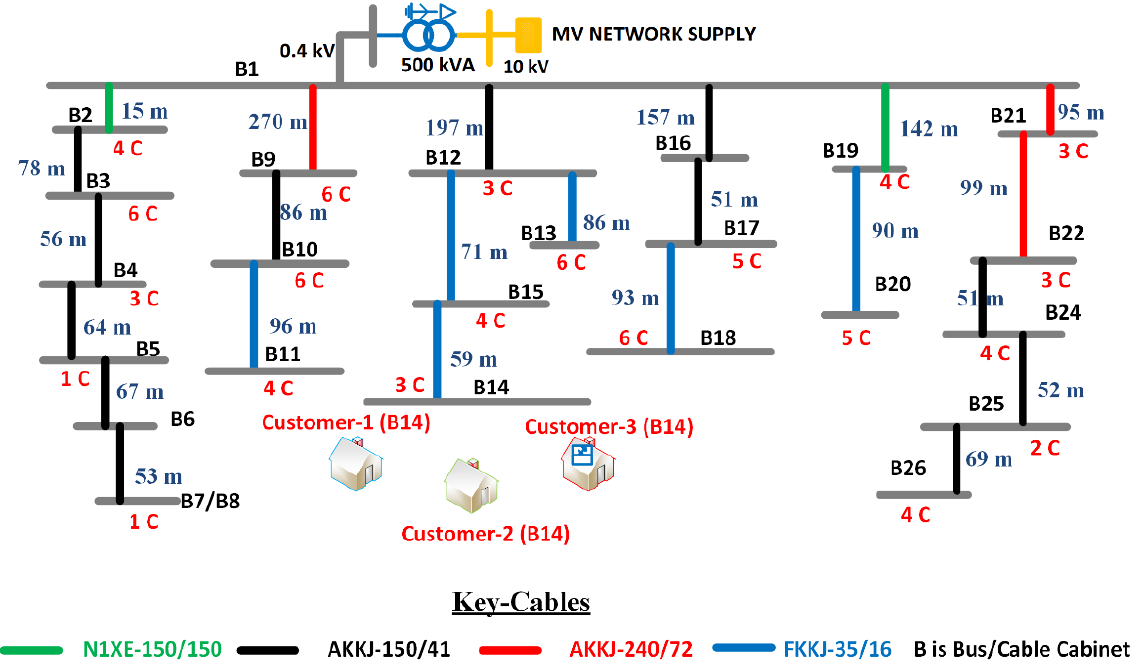
Figure 2. The study distribution network with 83 ‐ customers connected.